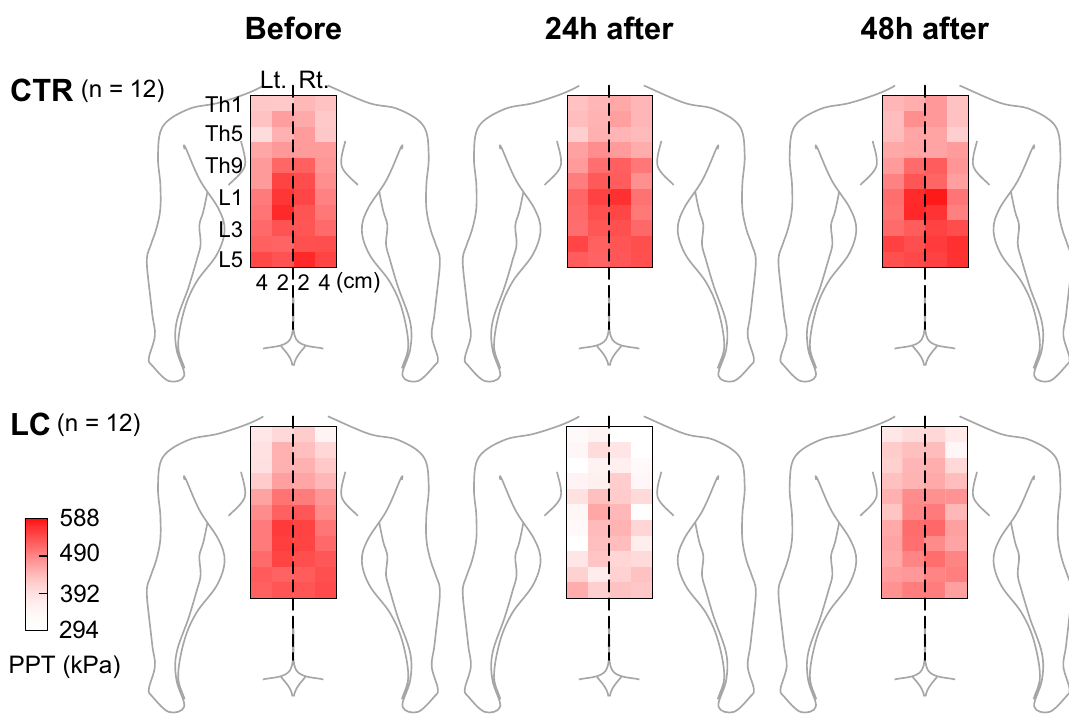
Figure 4. Heatmap images of pressure pain thresholds (PPTs) after lengthening contractions (LCs). Note a remarkable decrease in PPTs 24 h after LC in the LC group, which appeared to recover 48 h after LC. In the CTR group, PPT maps appeared to be the same 0 (before), 24, and 48 h after LC. Mean PPTs ranged from 294 to 588 kPa. See Supplementary Table 2 for detailed PPT